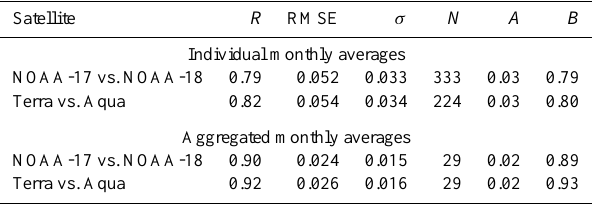
Table 5. Intersatellite comparison of monthly average τ a between NOAA-17 and NOAA-18, Terra and Aqua, respectively. The indi- vidual monthly averages are the monthly averages of each site in Table 1 separately (max. 435 possible values). For the aggregated values, all sites are averaged for a particular month (max. 29 possi- ble values). The parameters are the same as in Table 3.